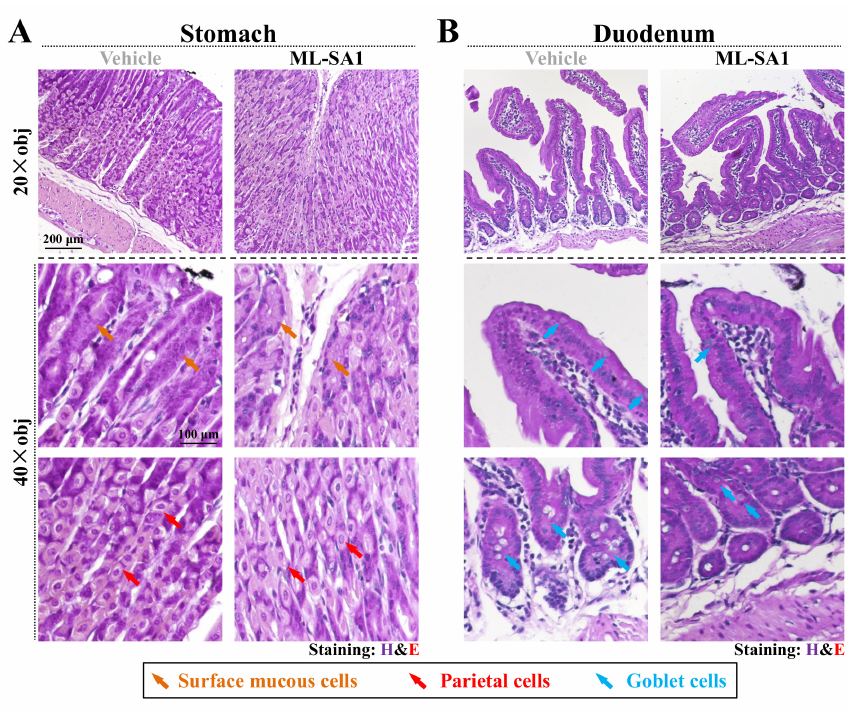
Figure 2. ML-SA1 treatment altered the morphology of stomach and duodenum of mice. (A) The H&E staining of stomach sections from the vehicle-treated or ML-SA1-treated mice. Orange arrow, surface mucous cells lining the up-edge of the pits; Red arrow, parietal cells lining the medium parts of the pits. Scale bar, 200 μm for the 20× objective lens and 100 μm for the 40× objective lens. (B) The H&E staining of duodenum sections from the vehicle-treated or ML-SA1-treated mice. Blue arrow, goblet cells in the villi of